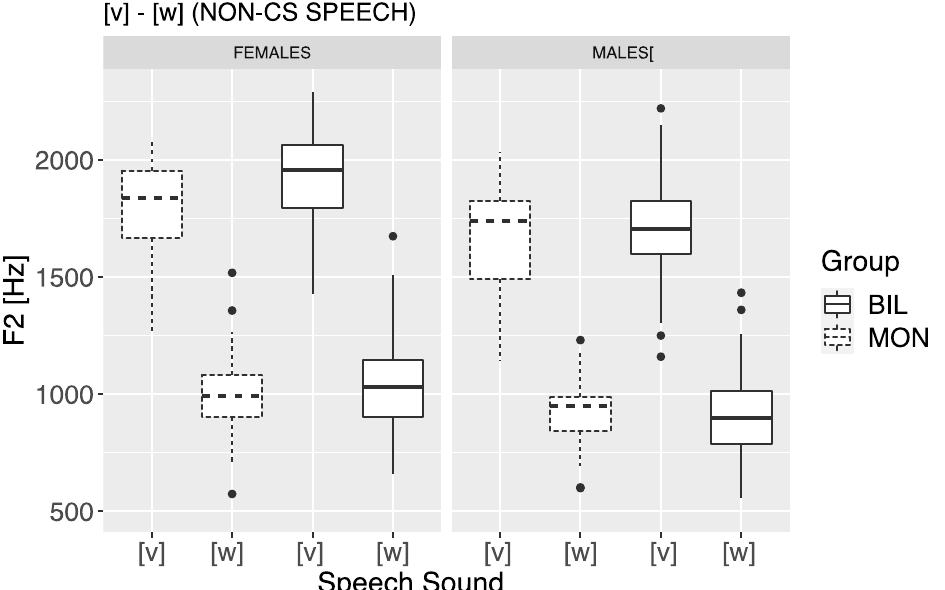
Figure 1. The F2 of intended [v] and [w] sounds in English words, spoken by MON (dashed) and BIL speakers (solid) in non-CS environments. The left panel shows data for females, the right panel for males.